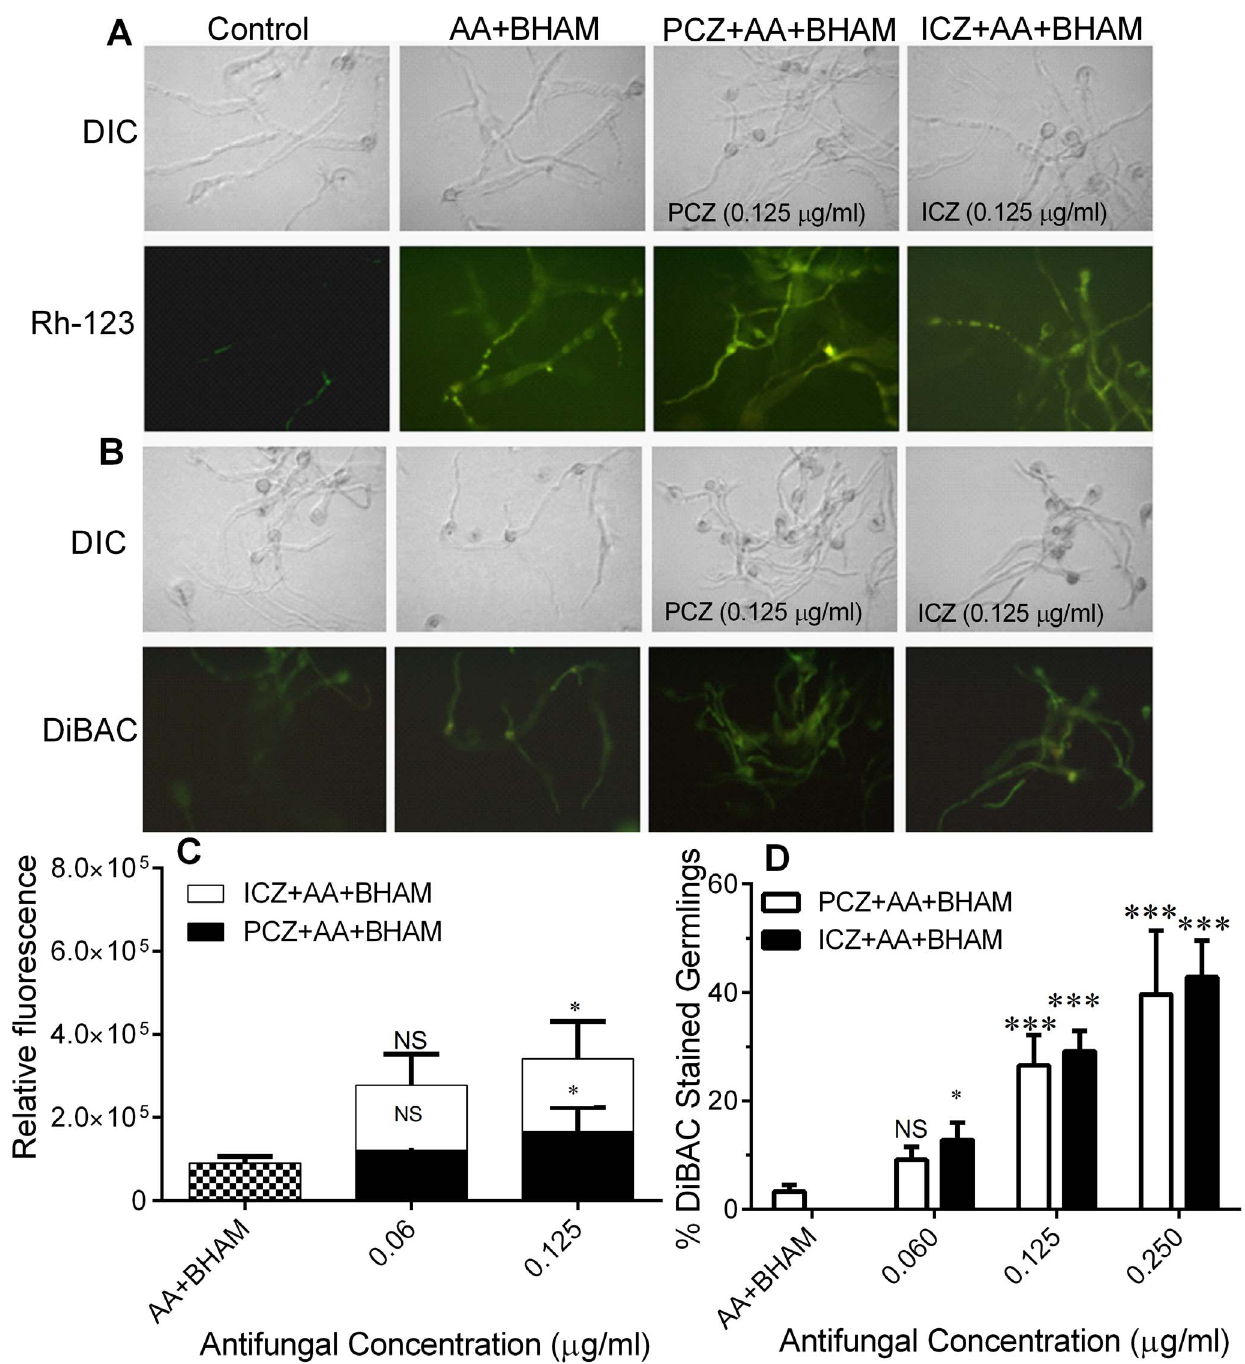
Figure 2. Changes in DY m and plasma membrane depolarization in R.oryzae germlings triggered by treatment with PCZ or ICZ combined with AA and BHAM. (A) Stains of germlings with Rh-123 showing increased green fluorescence, indicating loss of DY m . (B) Staining of germlings with DiBAC showing increased green fluorescence, indicating loss of viability owing to increased membrane permeability. DIC, differential interference contrast. (C) Relative fluorescence of germlings stained with Rh-123. (D) Percentages of R. oryzae germlings stained with DiBAC. *, p , 0.05, ***, p , 0.0001, while NS, p . 0.05, compared to AA + BHAM treated controls.